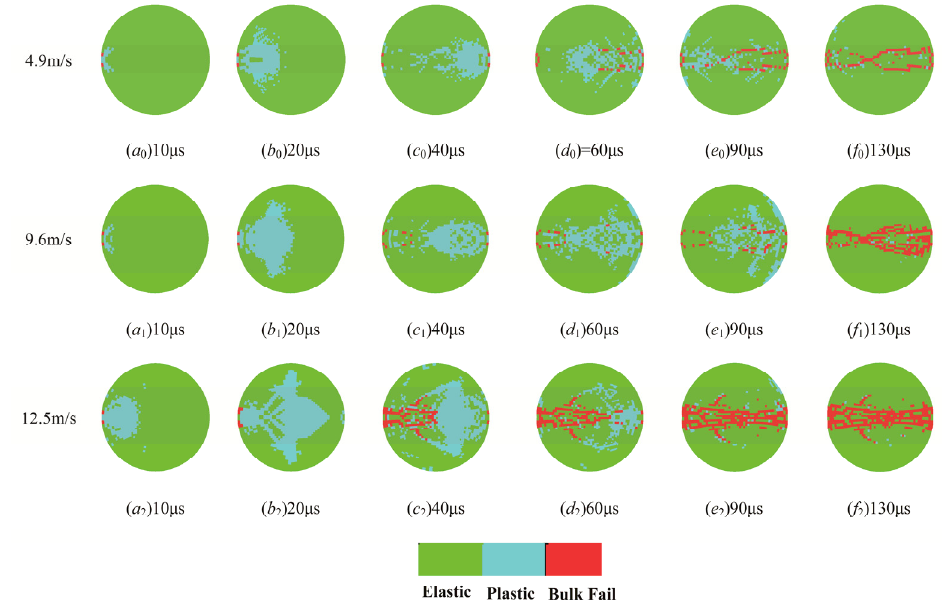
Figure 3. Crack evolution of disc specimens under dynamic load.